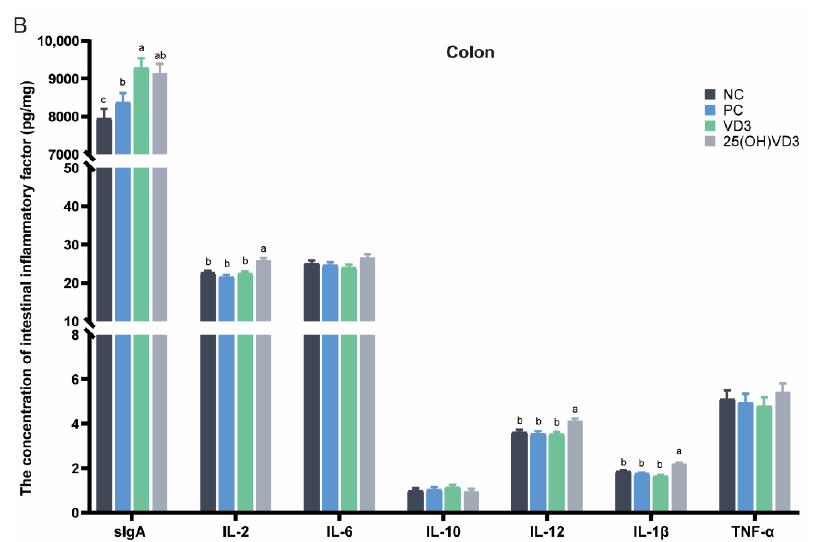
Figure 3. Effect of VD 3 and 25(OH)VD 3 on the intestinal immune function of weaned piglets. ( A ): The concentration of intestinal inflammatory factors in the ileum. ( B ): The concentration of intestinal inflammatory factors in the colon. Note: Different letters on the top of the column indicate significant differences ( p < 0.05), n = 6. NC, negative control; PC, positive control; VD 3 , vitamin D 3 ; 25(OH)VD 3 , 25-hydroxyvitamin D 3 .